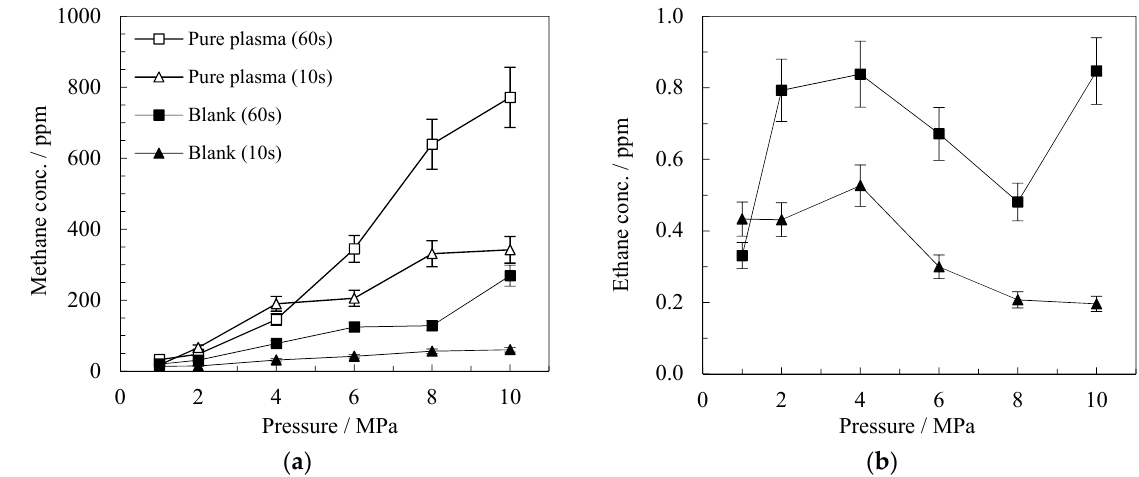
Figure 1. The influence of pressure on the hydrocarbon concentration for plasma-catalytic FTS (NTP + Blank catalyst) at discharge times of 10 and 60 s; ( a ) methane and ( b ) ethane. Legend: □ —Pure plasma (60 s); Δ —Pure plasma (10 s); ■ —Blank (60 s); ▲ —Blank (10 s). Operating conditions: Syngas (H 2 /CO) ratio: 2.2:1; current: 350 mA; inter-electrode gap: 1 mm; wall temperature: 25 °C. Error bars (vertical): Expanded experimental hydrocarbon concentration uncertainty of ±11%.